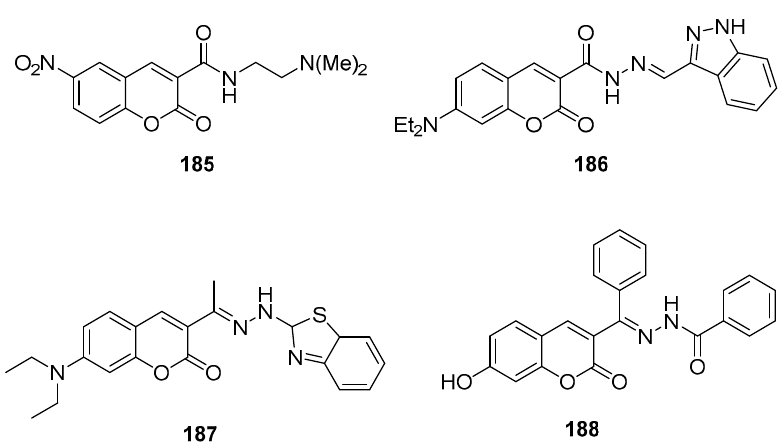
Figure 60. Coumarin fluorescent probes for copper (II) detection.